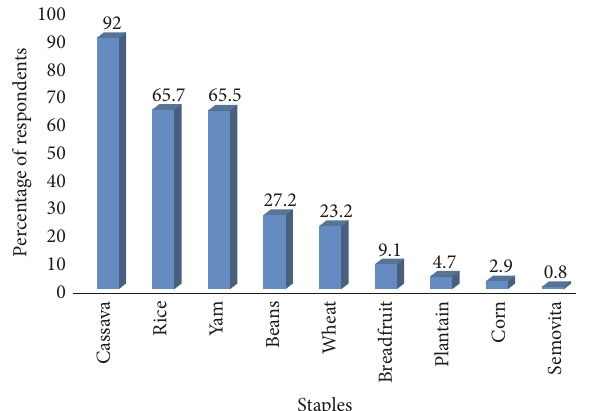
Figure 1: Consumption frequencies (in percentage) of foods in urban and rural communities of South-eastern Nigeria obtained from 24-hour dietary